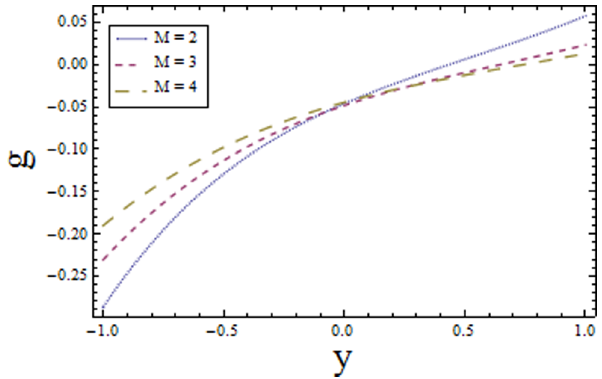
Figure 18. Plot of concentration g for heterogeneous reaction parameter M with E ~ 0 : 2 , t ~ 0 : 1 , x ~ 0 : 1 , Sc ~ 1 : 5 and K ~ 0 : 5 .